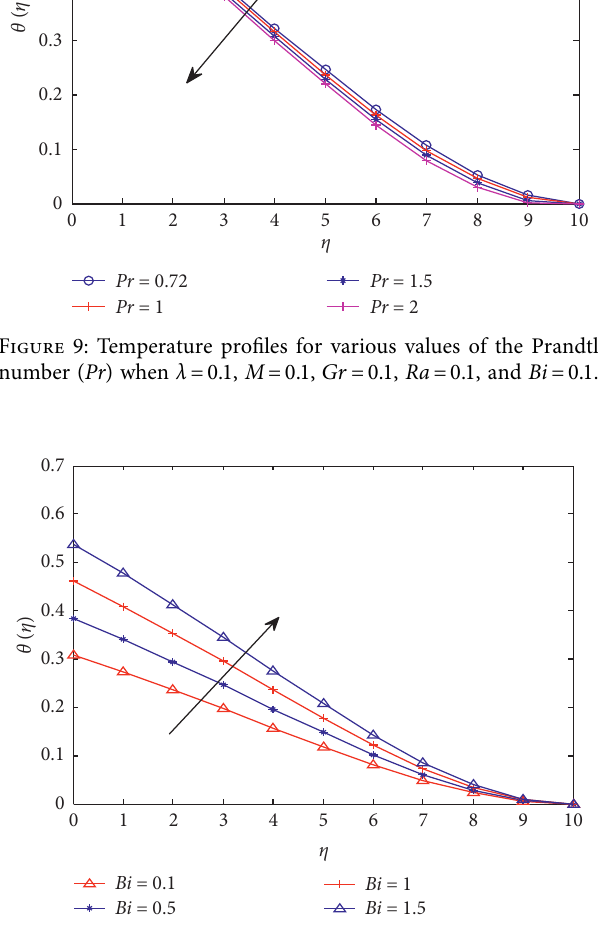
Figure 10: Temperature profiles for various values of the Biot number ( Bi ) when λ � 0.1, M � 0.1, Gr � 0.1, Ra � 0.1, and Pr �